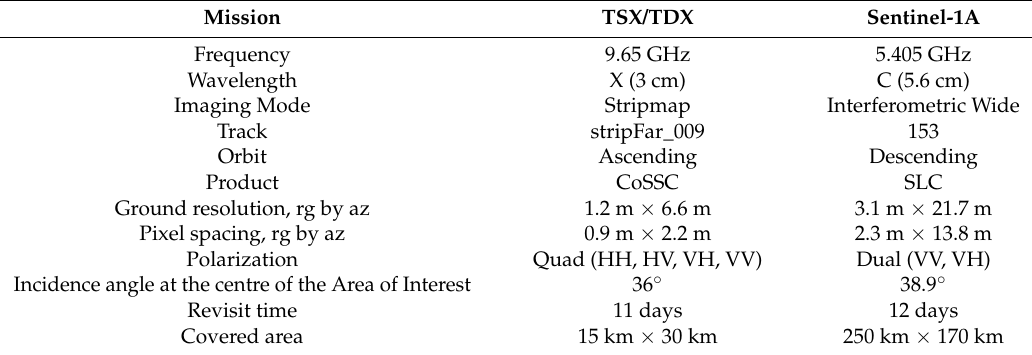
Table 2. X-band TerraSAR-X/TanDEM-X (TSX/TDX) and Sentinel-1A data characteristics. Mission TSX/TDX